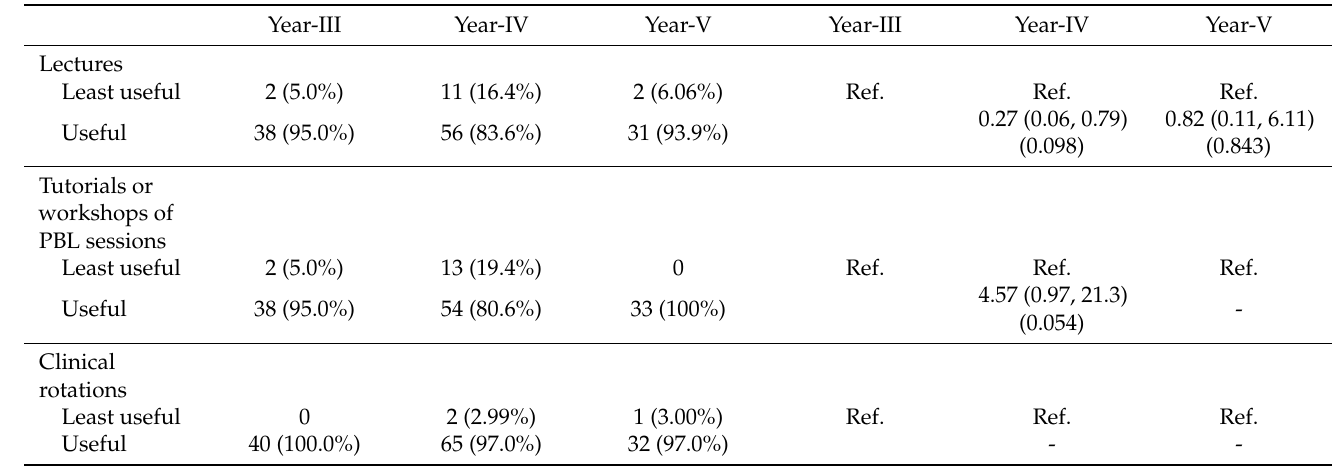
Table 6. Frequency and odds of student years in the relative effectiveness of various instructional modes in gaining and retaining the knowledge of medicines and prescribing, including but not limited to antibiotics prescribing (No significant differences were